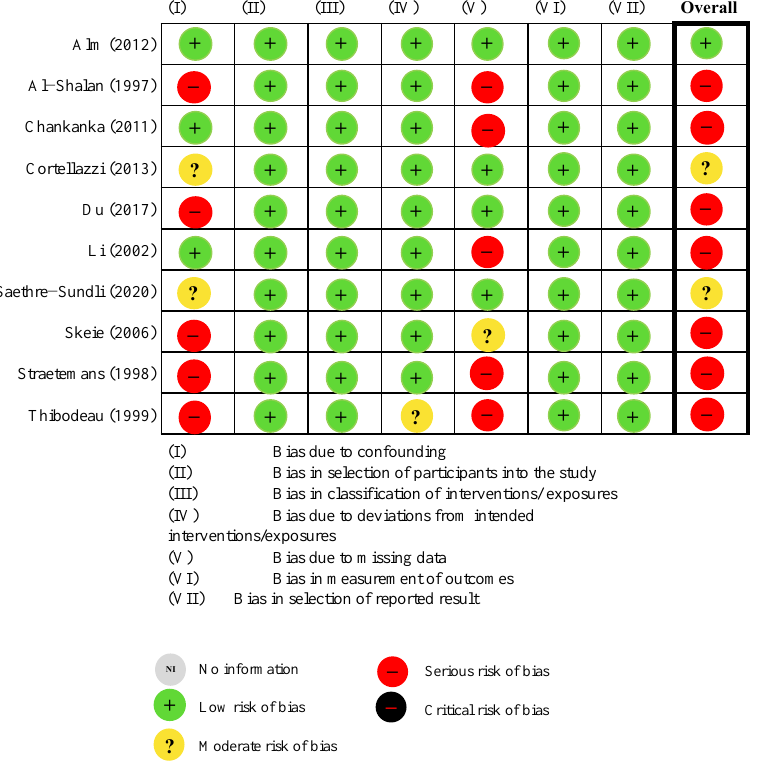
Figure 2. Risk of bias assessment.